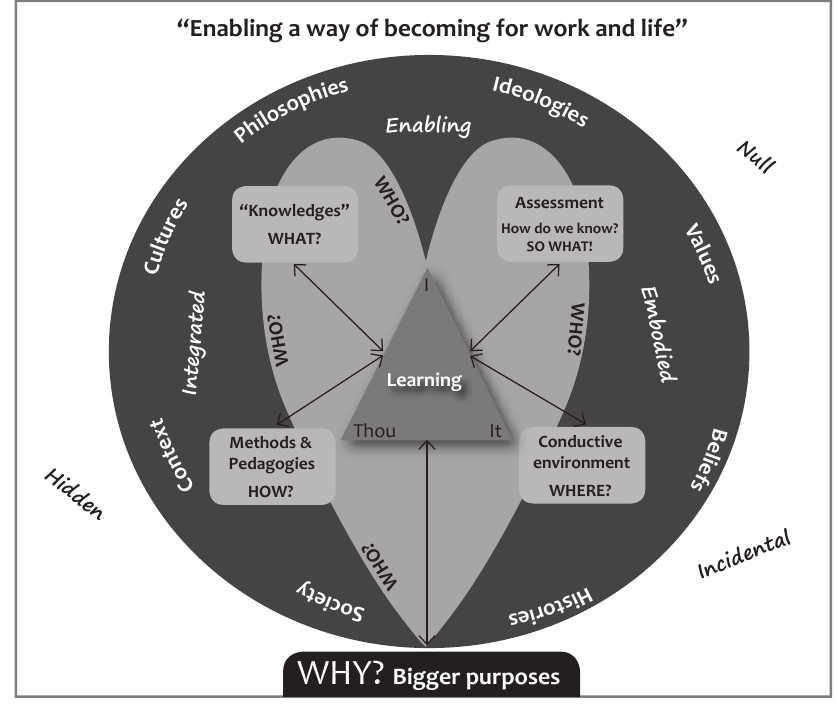
Figure 2: NMMU Faculty of Education’s Humanising Curriculum Framework (NMMU 2013) There are several layers of meaning encapsulated in this diagram. The outer layer of the circle acknowledges that our work in education, and all who engage in it,